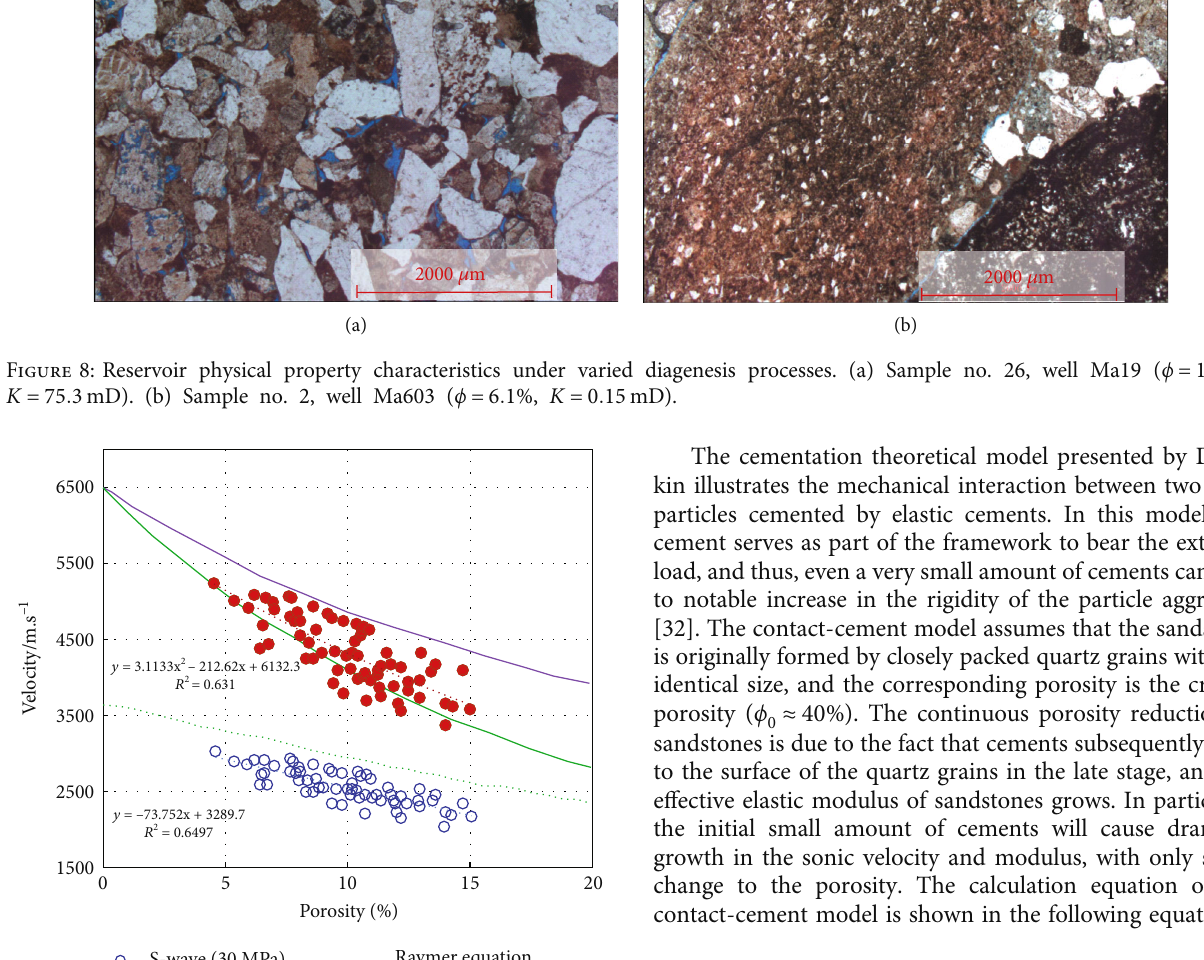
y = –73.752x + 3289.7 R 2 = 0.6497